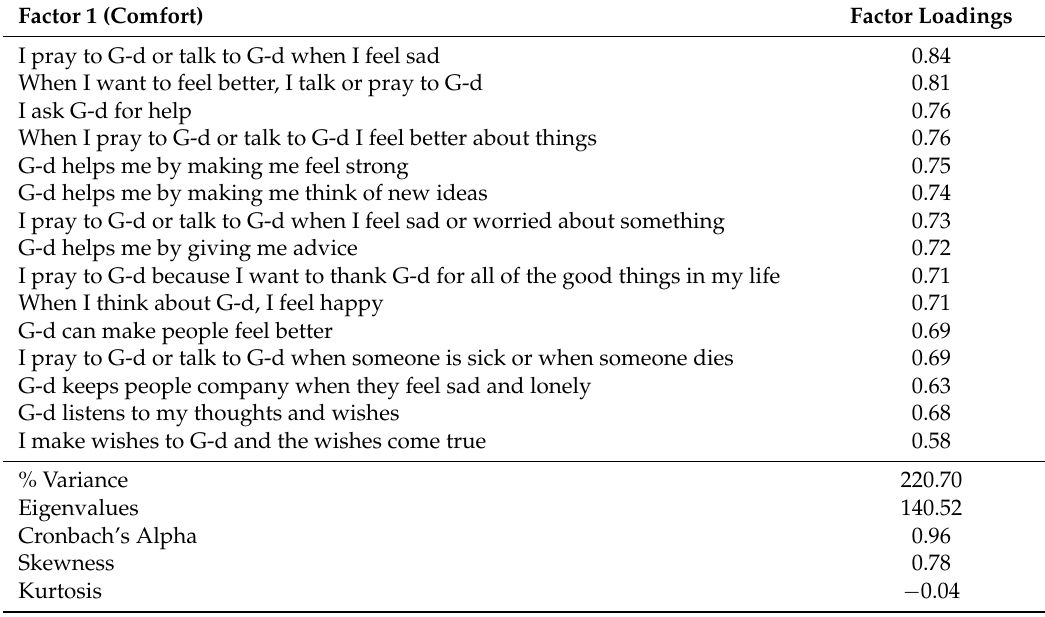
Table 2. Factor loadings for exploratory factor analysis with Varimax